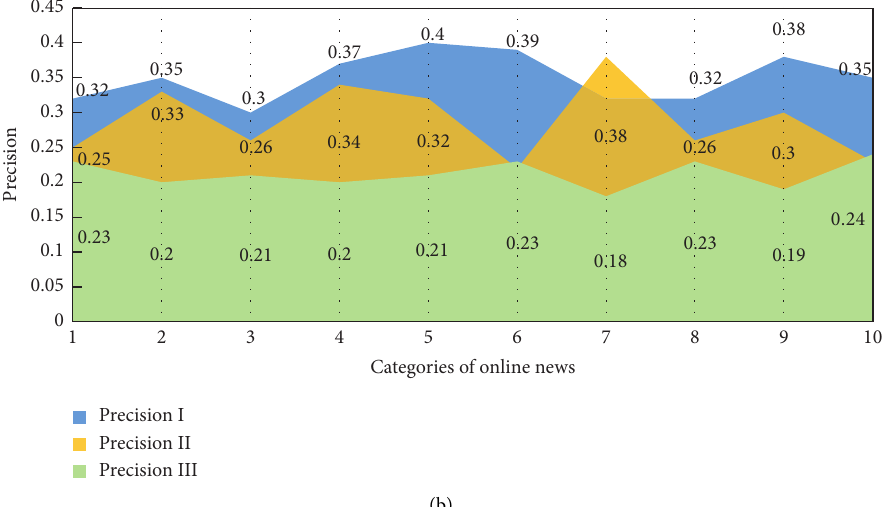
Figure 11: Quality comparative analysis of three parallel combination fusion schemes. (a) Recall comparison of three parallel combination fusion schemes. (b) Accuracy comparison of three parallel combination fusion schemes.